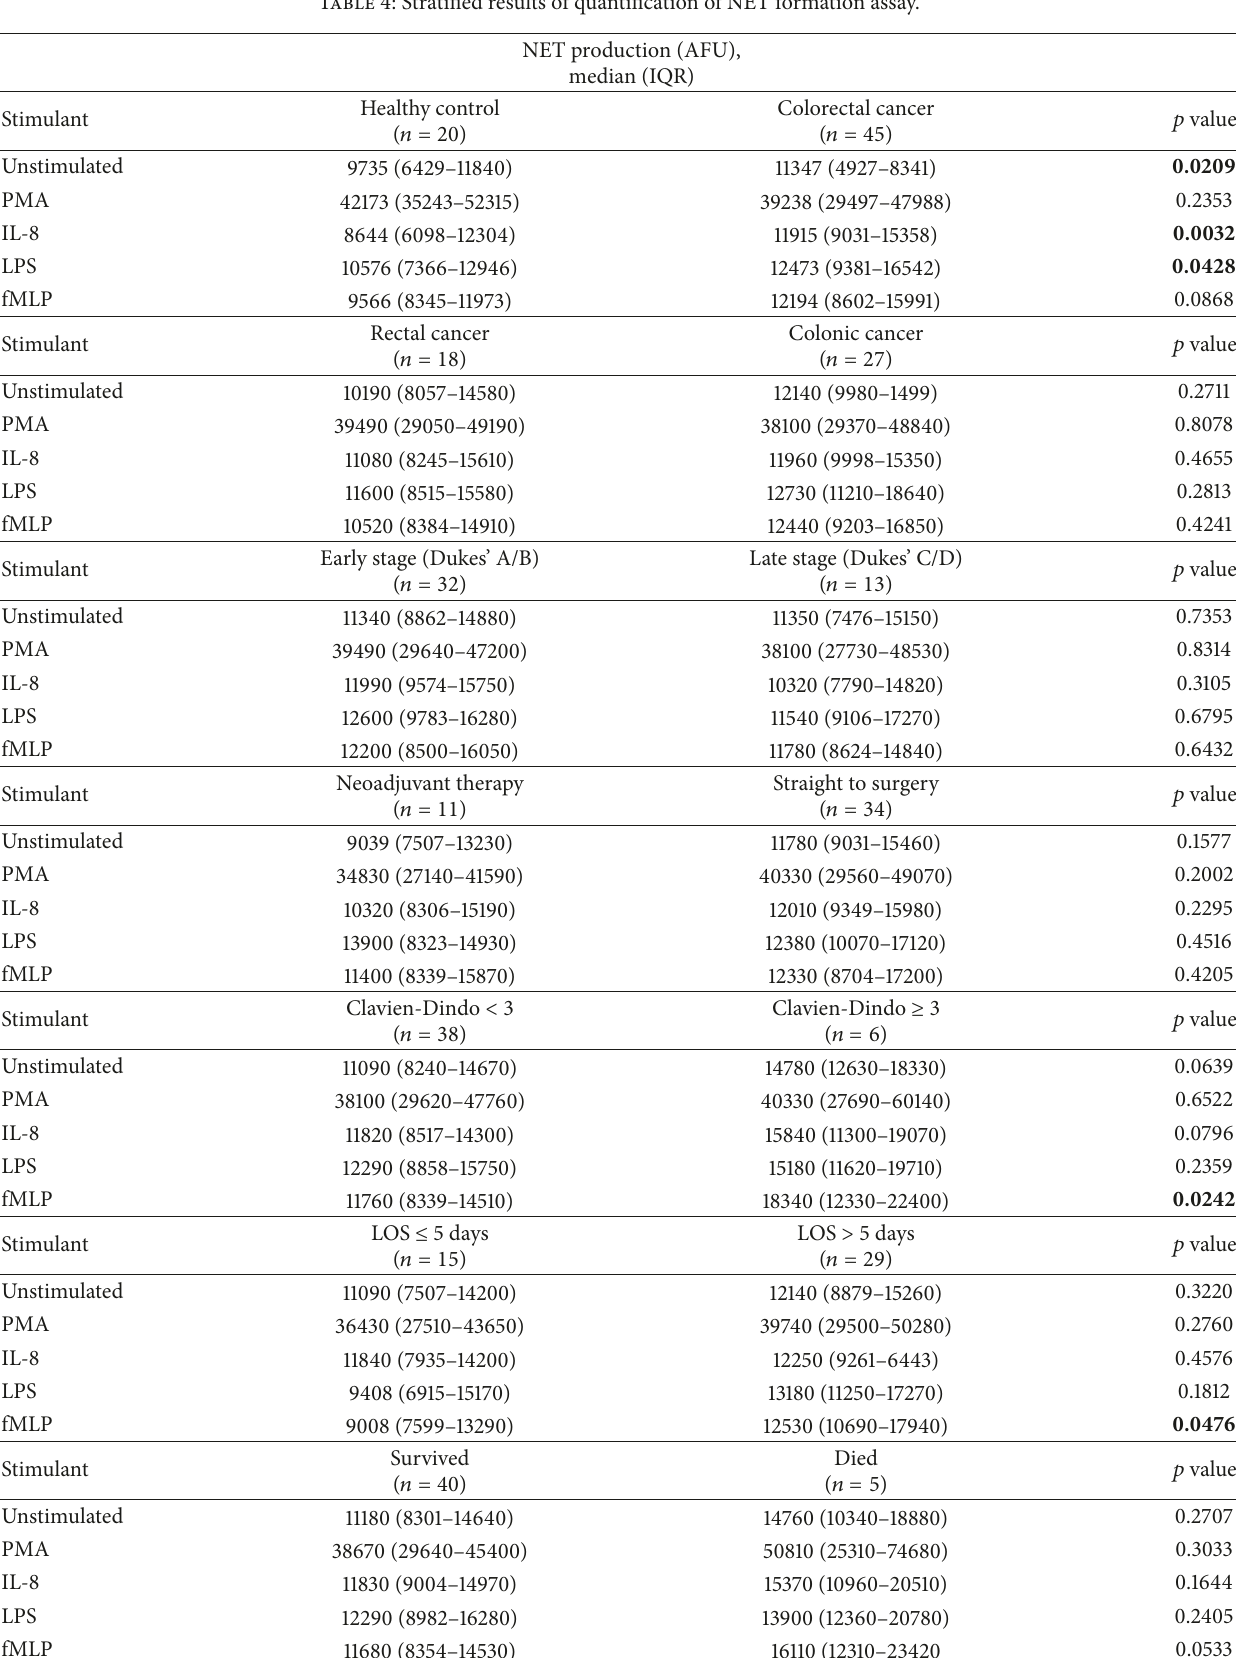
Table 4: Stratified results of quantification of NET formation